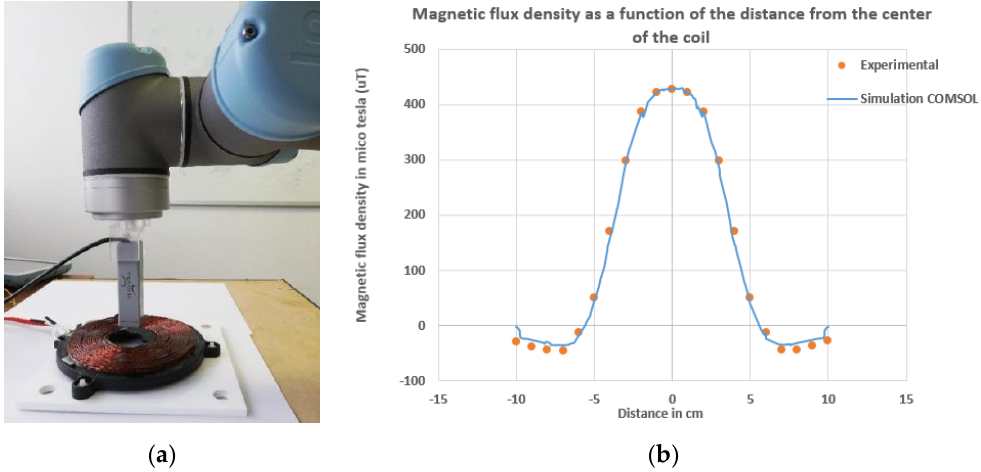
Figure 2. ( a ) measurement of magnetic flux density using magneto-resistive sensor; ( b ) experimental and simulation magnetic flux density as a function of distance.